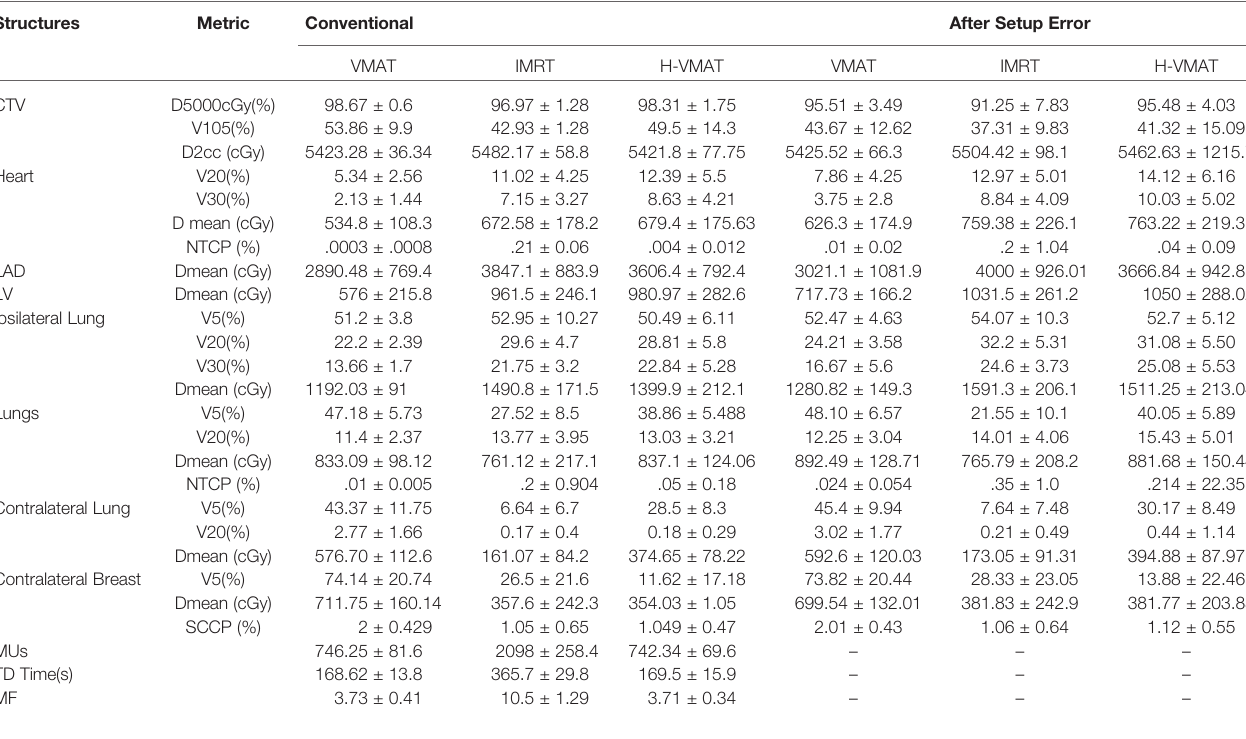
TABLE 3 | Summary of the dosimetric parameters, radiobiological indices, and delivery parameters.